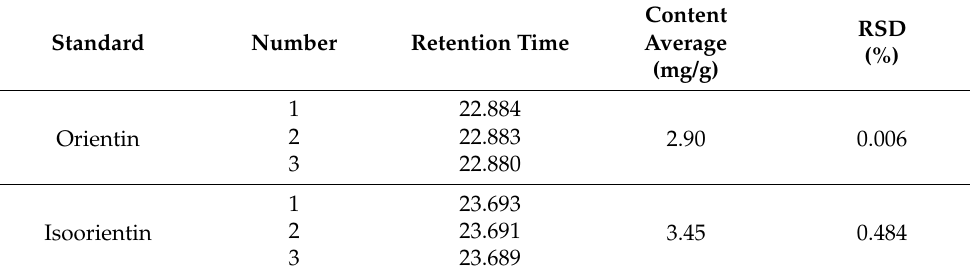
Table 4. Content of orientin and isoorientin in VB extract ( n = 3).